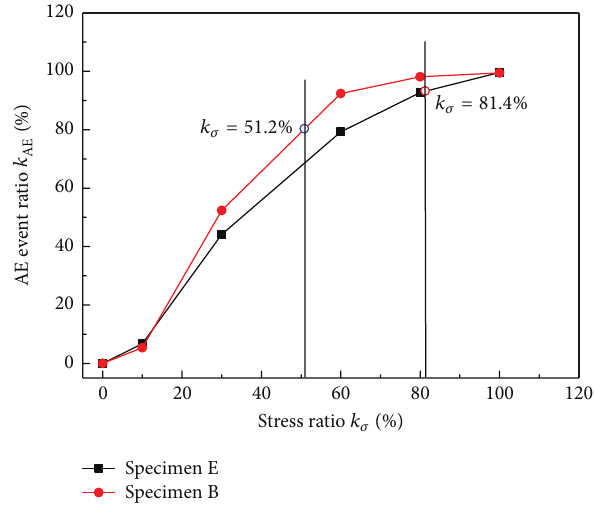
Figure 10: Relationship between stress ratio and AE events